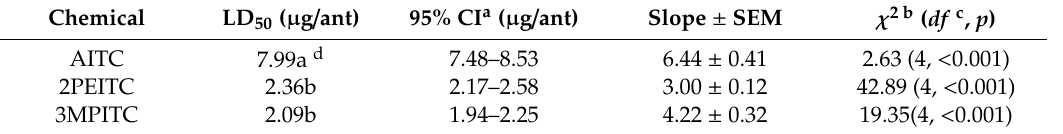
Table 1. Contact toxicity of three isothiocyanates against S. invicta workers.